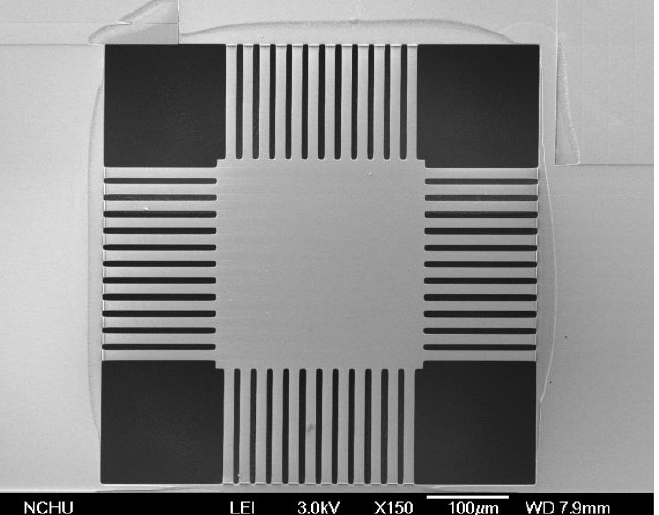
Figure 7. SEM image of the generator after the post-CMOS